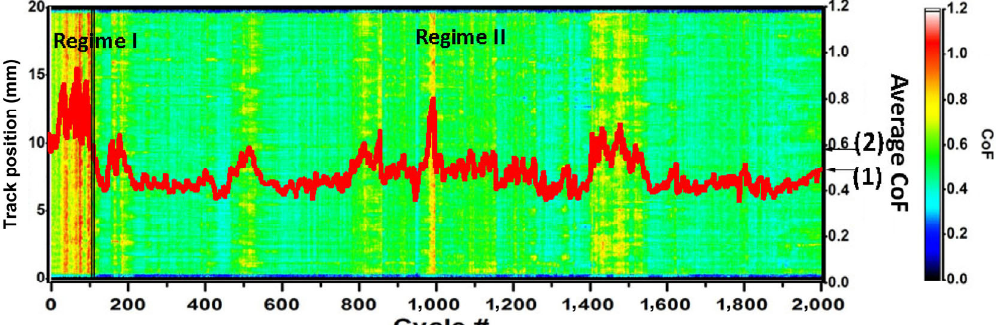
Fig. 16 Triboscopic image overlapped with average CoF indicating frequent occurrence of transfer film as compared to RH60 and